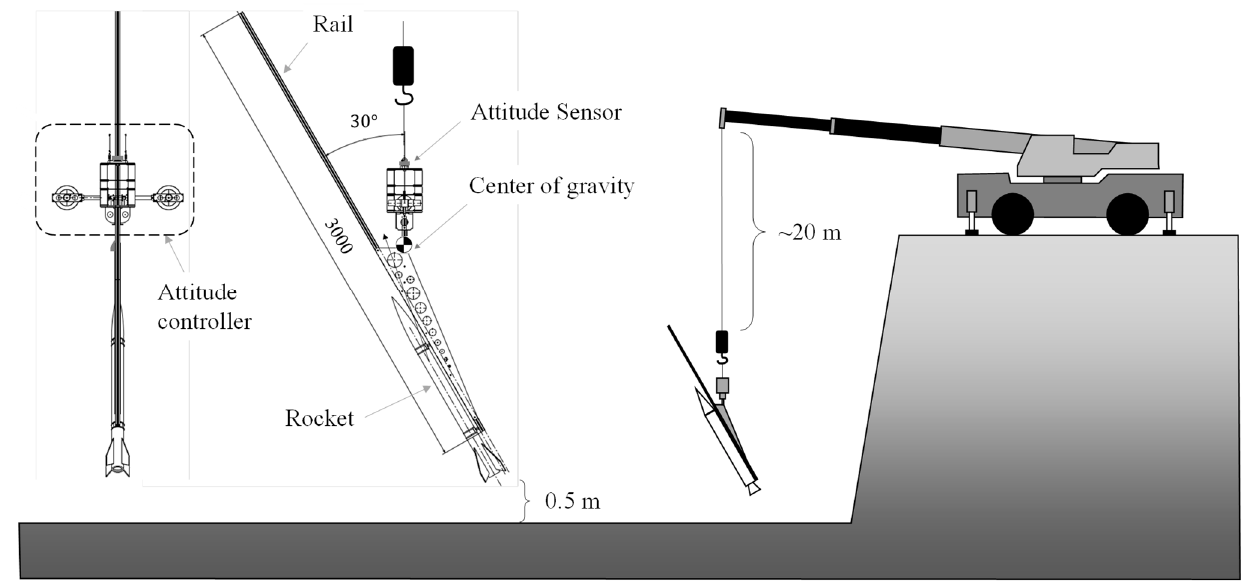
Figure 1. Rail launcher suspended via a crane.